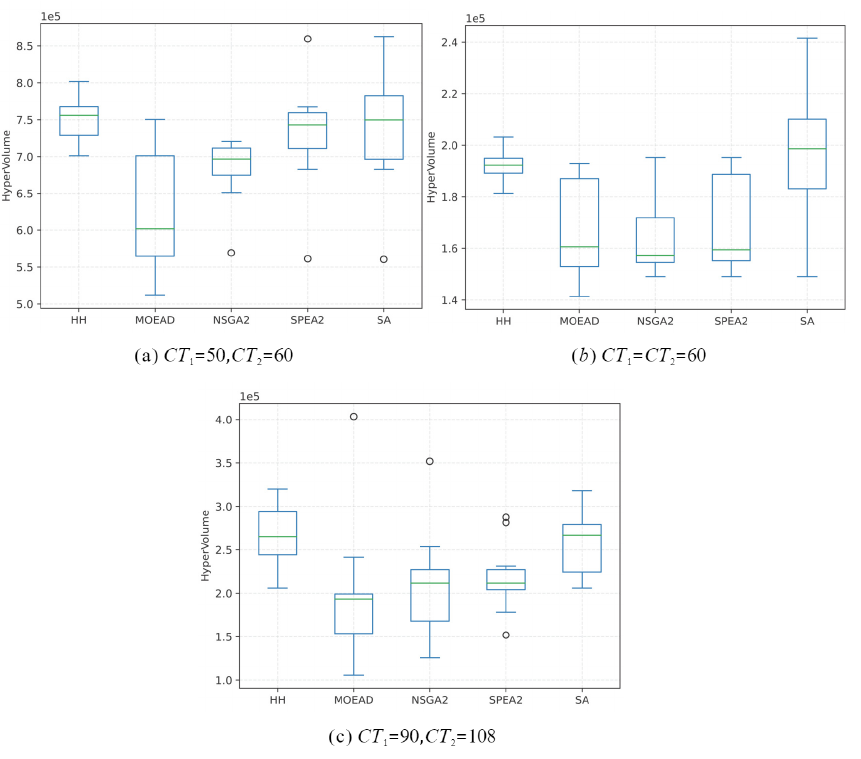
Figure 9. Box plots of